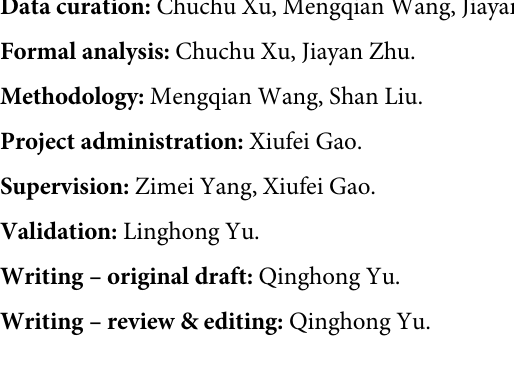
S2 Table. Characters of related ongoing studies. S3 Table. PRISMA Checklist 2020. S1 Fig. Forest plot of level of IL-8 in milk. S2 Fig. Forest plot of